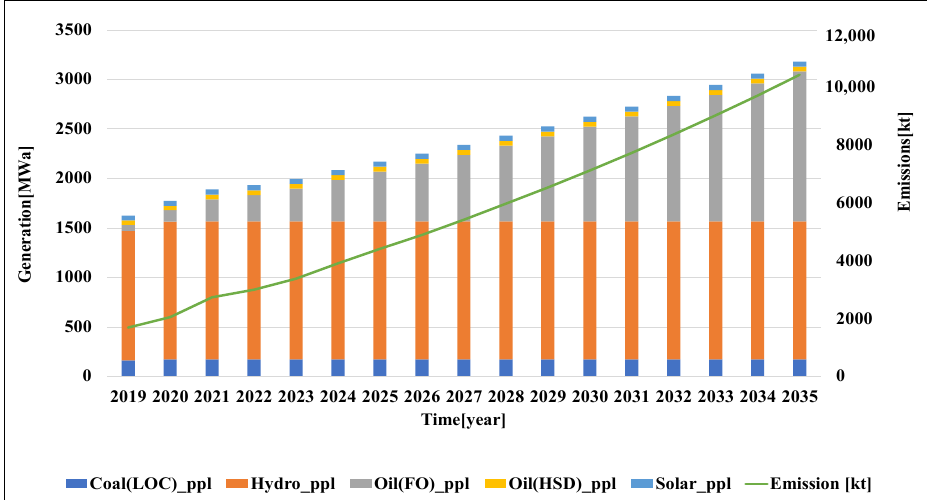
Figure 12. Electricity generation and emissions under the baseline scenario.